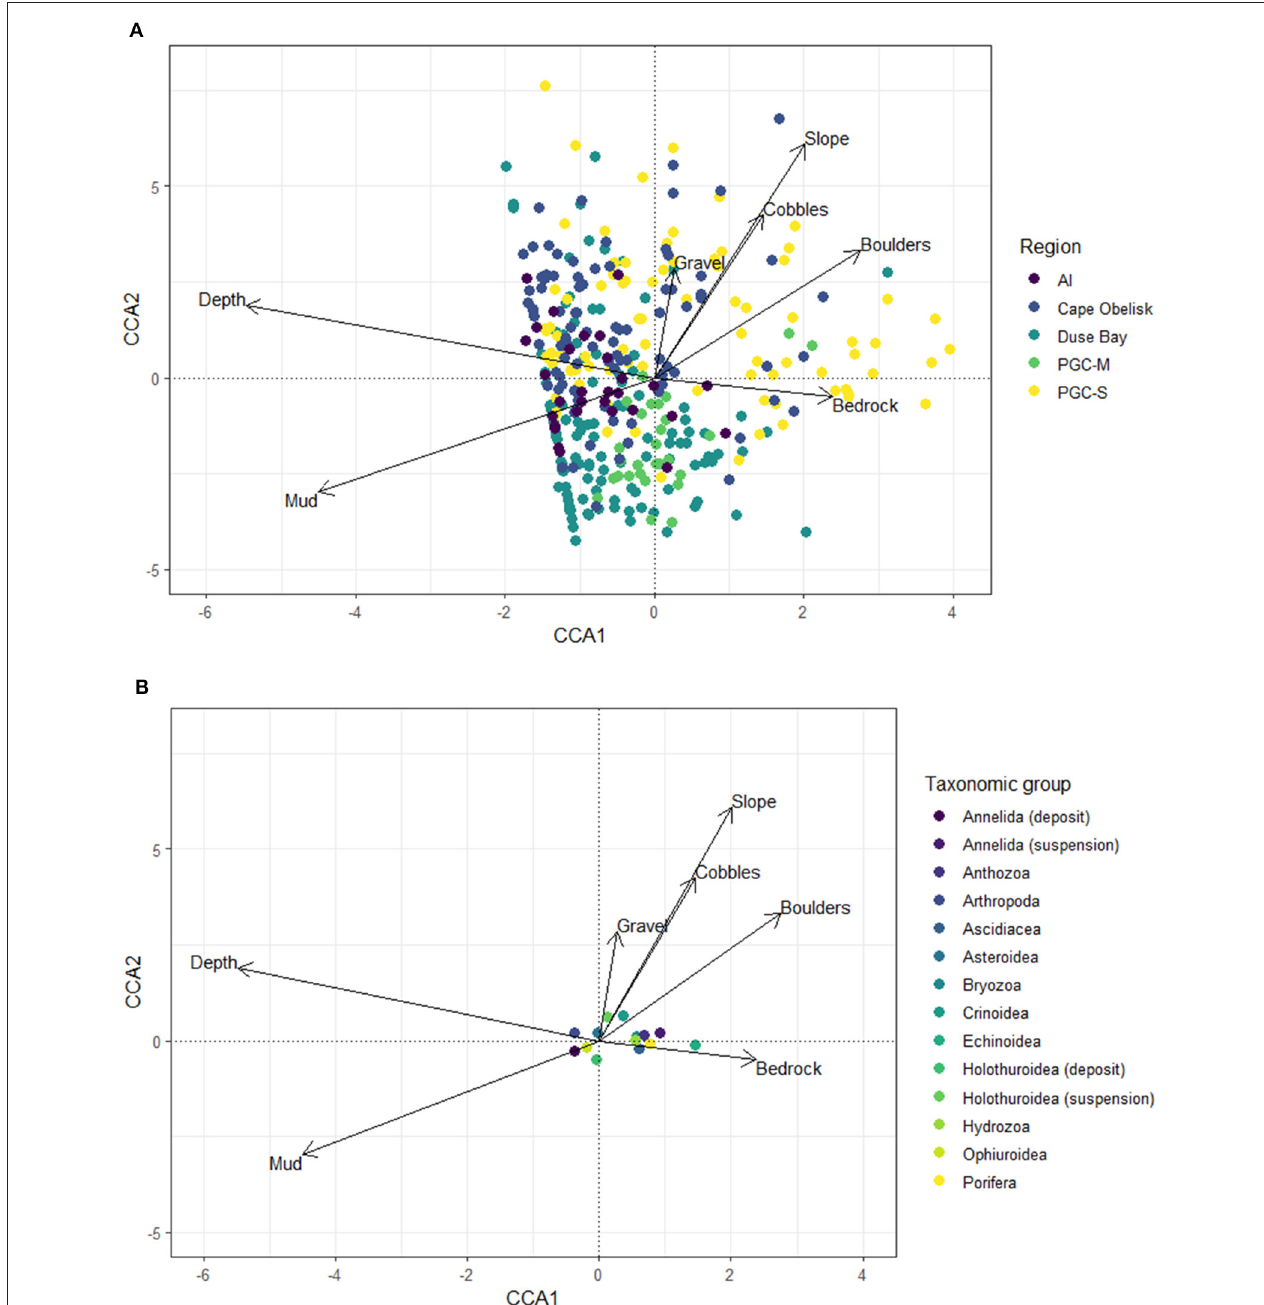
FIGURE 6 | Canonical Correspondence Analysis (CCA) of community assemblage and environmental variables including substrate cover, depth, and seafloor slope gradient. Organisms are grouped into higher taxonomic classifications and functional groups were necessary. (A) Site scores. (B) Taxon